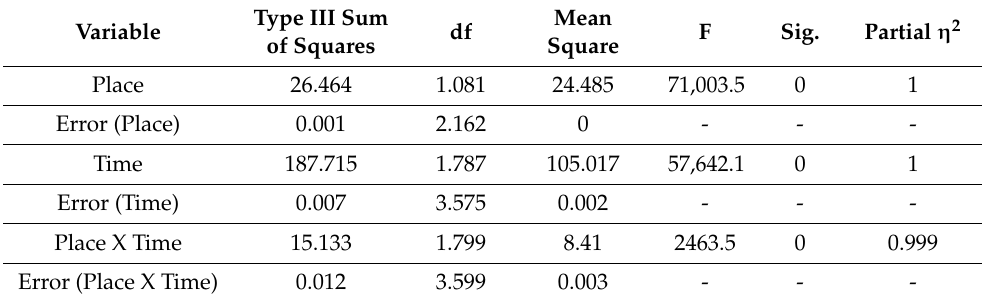
Table 4. Tests of within-subjects effects of leaf mass decay (g) in Lake H é v í z and through H é v í z